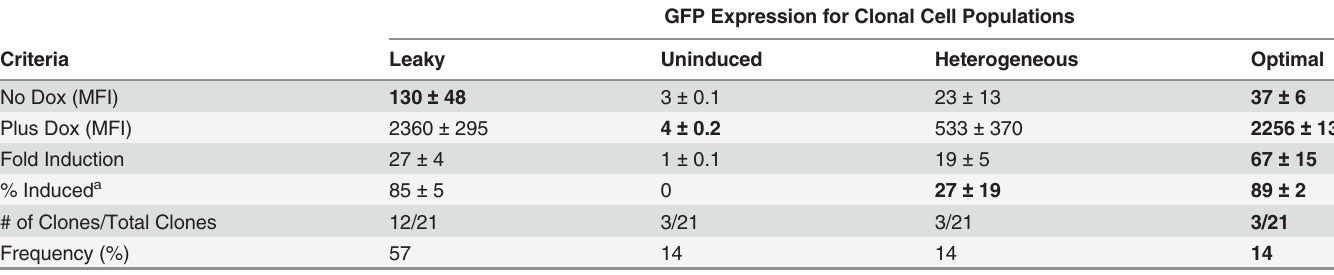
Table 1. Phenotypes of cell lines generated using a commercially available Tet-On vector system and random integration. GFP Expression for Clonal Cell